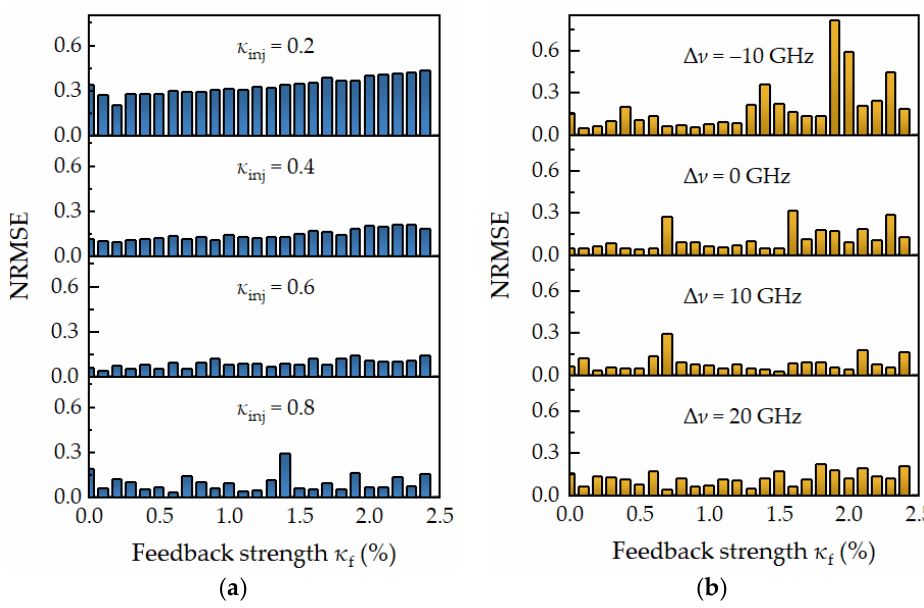
Figure 8. The distribution of NRMSE under ( a ) different injection strength κ inj ; ( b ) different frequency detuning Δ ν within the range of feedback strength κ f from 0 to 2.5% (interval is 0.1%).